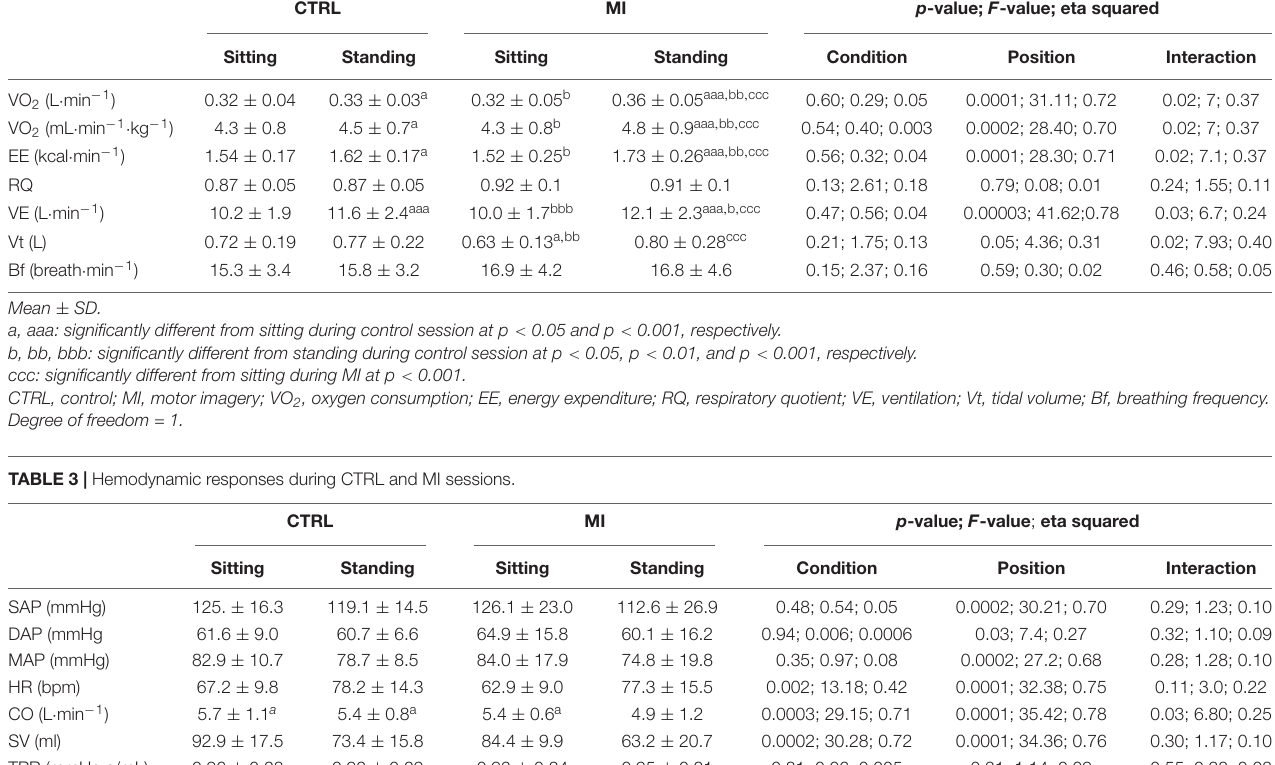
Sitting Standing Sitting Standing Condition Position